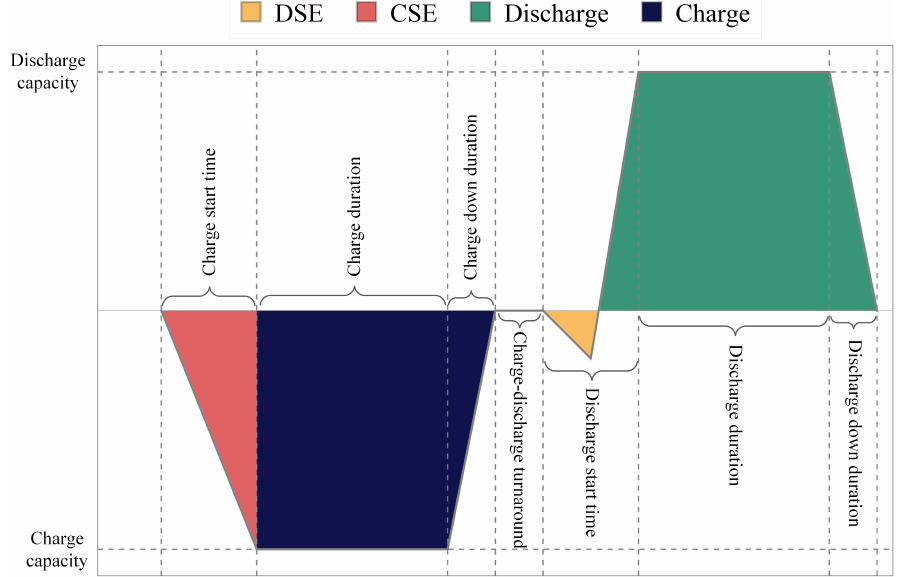
Figure 3. LAES cycle